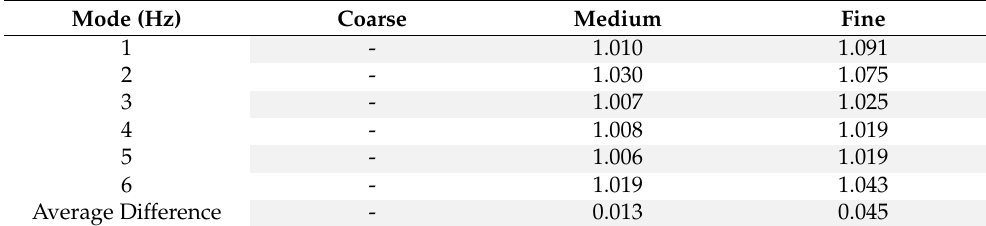
Table 14. Normalised sensitivity values relative to coarse mesh (Fully Fuelled